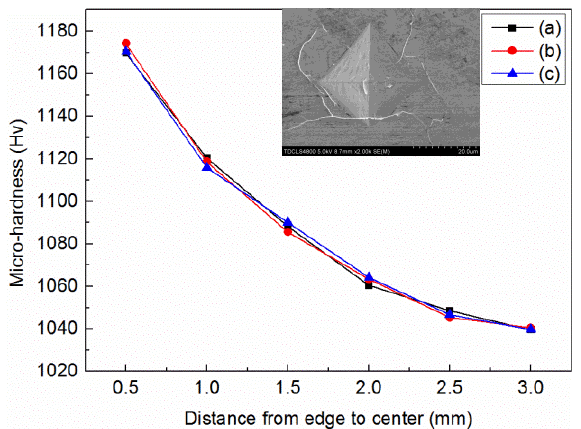
Figure 8. Change of micro-hardness from the edge to the center of the samples. Upper position (a), middle position (b) and lower position (c) of rod alloy.